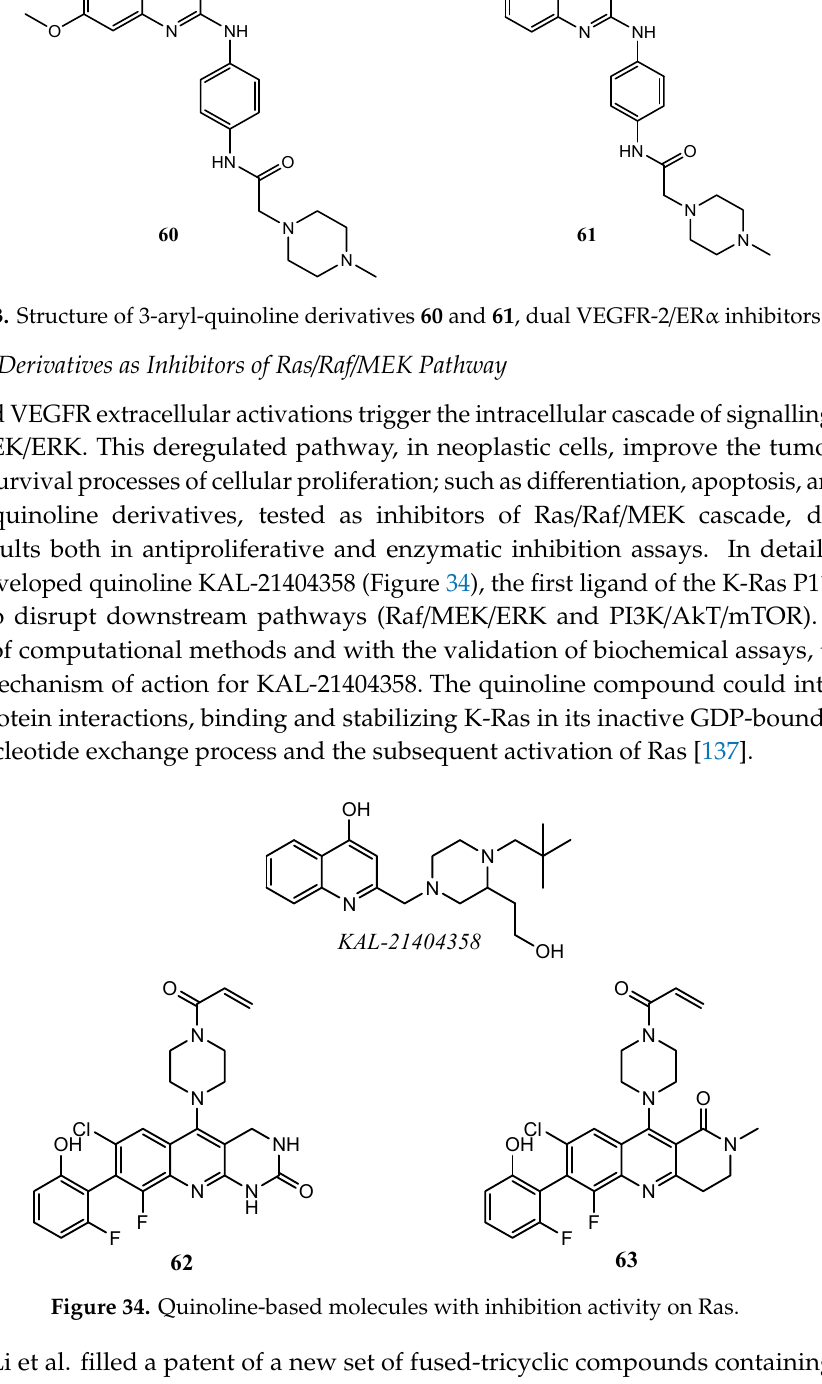
Figure 33. Structure of 3-aryl-quinoline derivatives 60 and 61 , dual VEGFR-2/ER α inhibitors [136] .